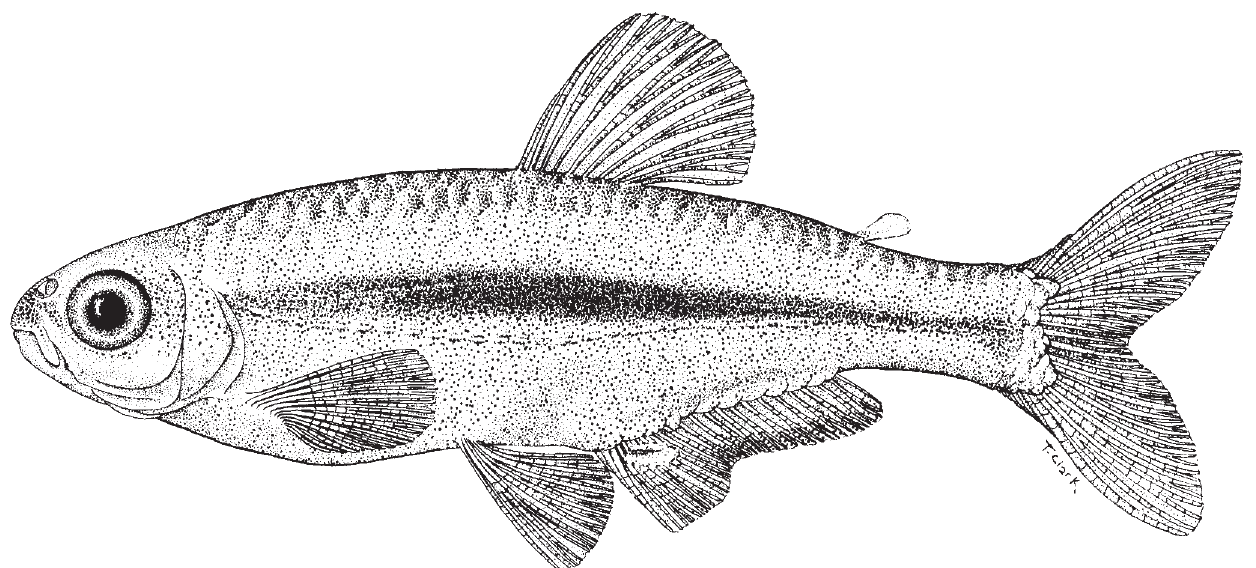
Fig. 4. Bryconadenos tanaothoros , new species, MZUSP 85852, SL 41.3 mm, adult male, holotype. Brazil: Mato Grosso, Serra do Roncador, tributary of rio Suiá-Missu, rio Xingu